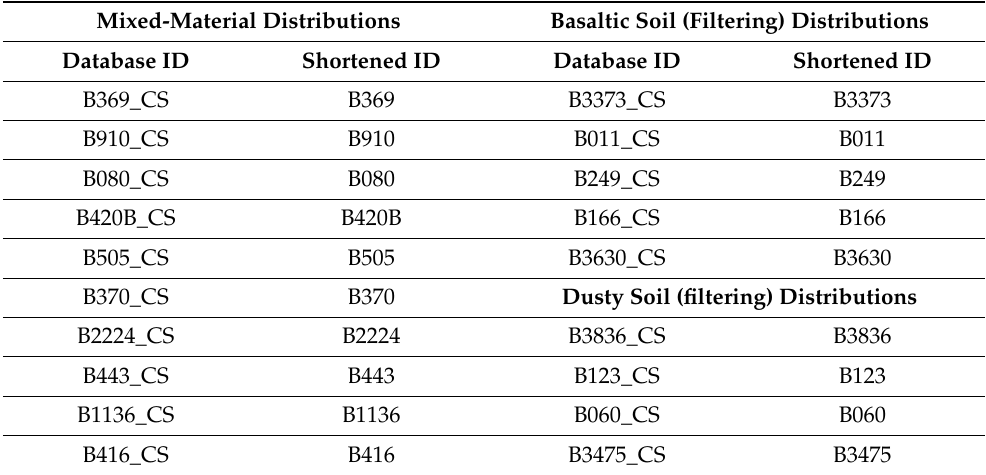
Table 1. List of Distribution Identifiers. The numbers in these IDs refer to the sol on which the APXS measured the target